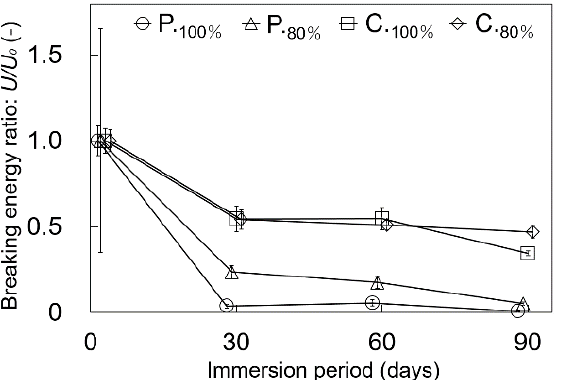
Figure 15. Comparison of the changes of the tensile breaking energies of the four test piece types brought about by the immersion. Average ± S.D., N = 5.